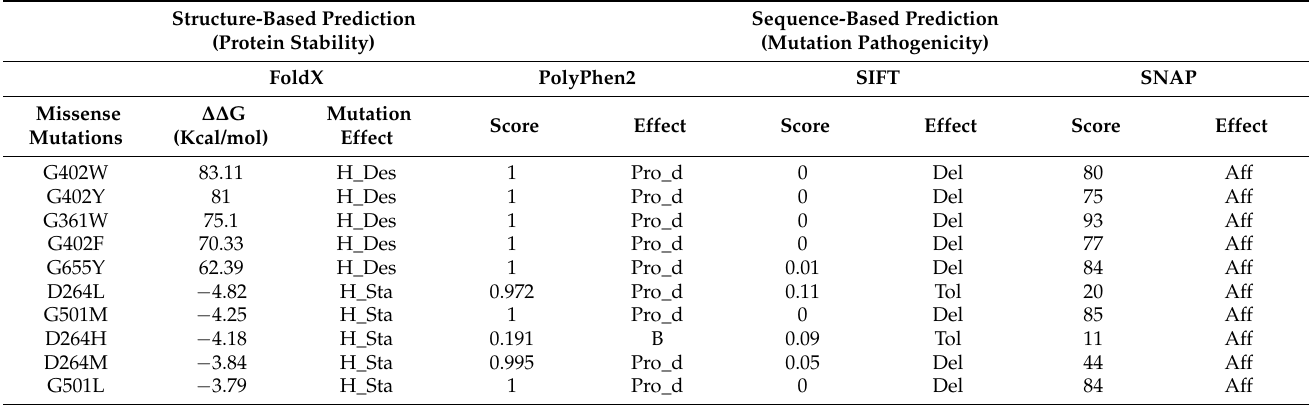
Table 1. Functional effects of top ten mutations altering MPO protein stability.